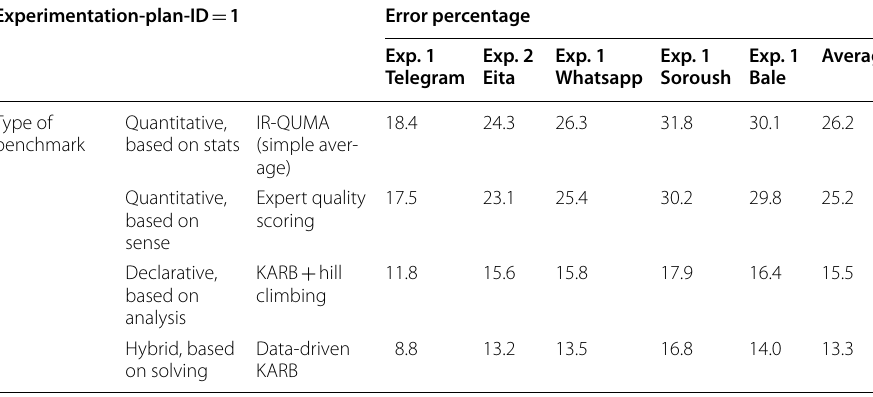
Table 1 Evaluation results (for Experimentation-Plan-ID-1) Experimentation-plan-ID =